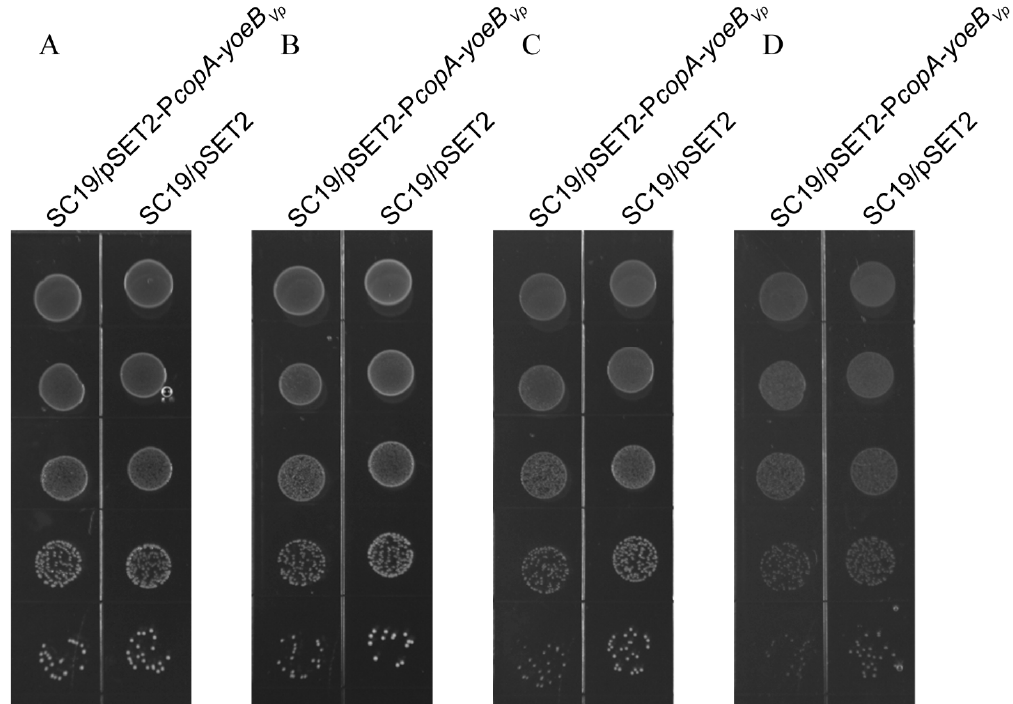
Figure 3. YoeB Vp expression resulted in growth defect in S. suis on agar plates. The SC19/pSET2-P copA - yoeB Vp and SC19/pSET2 strains were grown in the absence ( A ) and presence of various concentrations of CuSO 4 ( B – D ); ( B ) 0.1 mM CuSO 4 ; ( C ) 0.2 mM CuSO 4 ; ( D ) 0.5 mM CuSO 4 . The images are representative of at least three independent experiments.